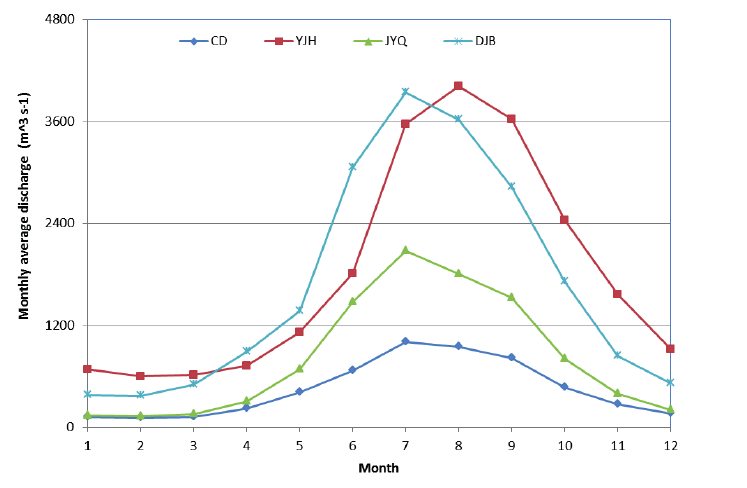
Fig. 2 The seasonal variation at four stations.